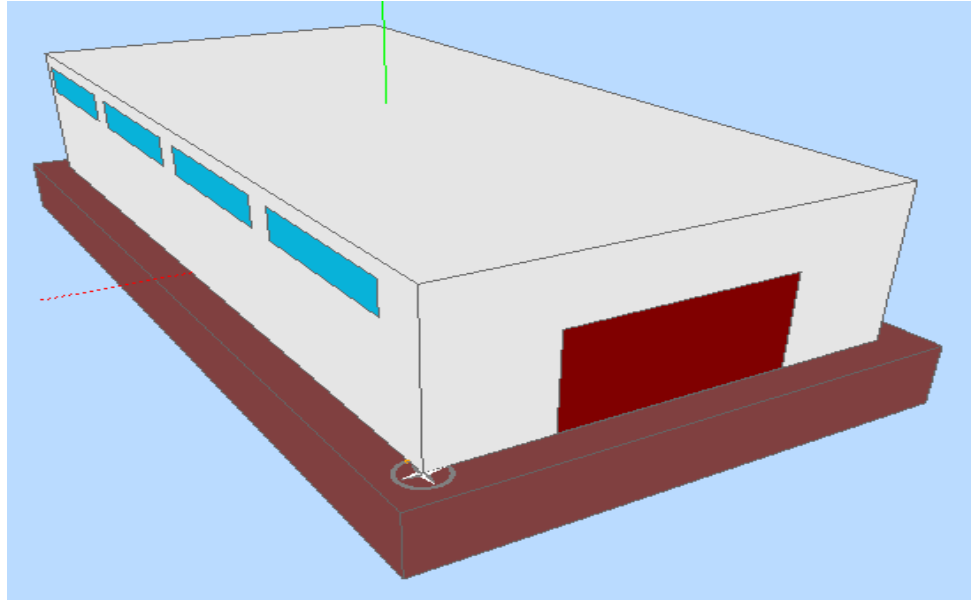
Figure 1. Industrial shed model.